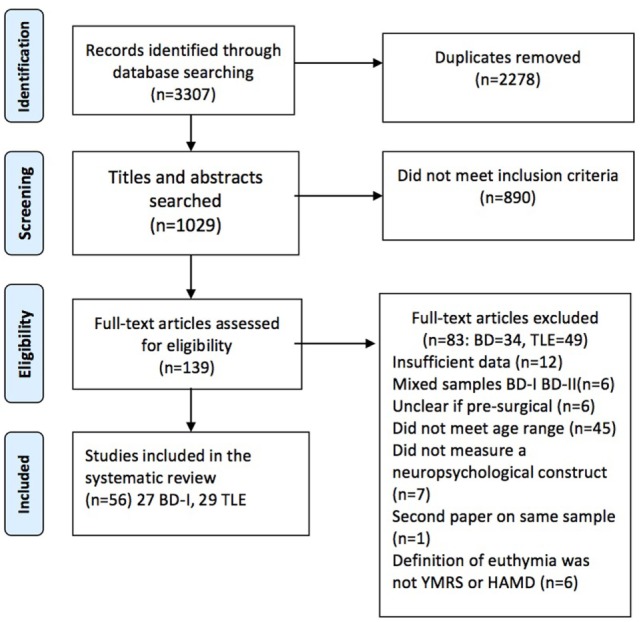
Preferred Reporting Items for Systematic Reviews and Meta-Analyses flow diagram of included studies.